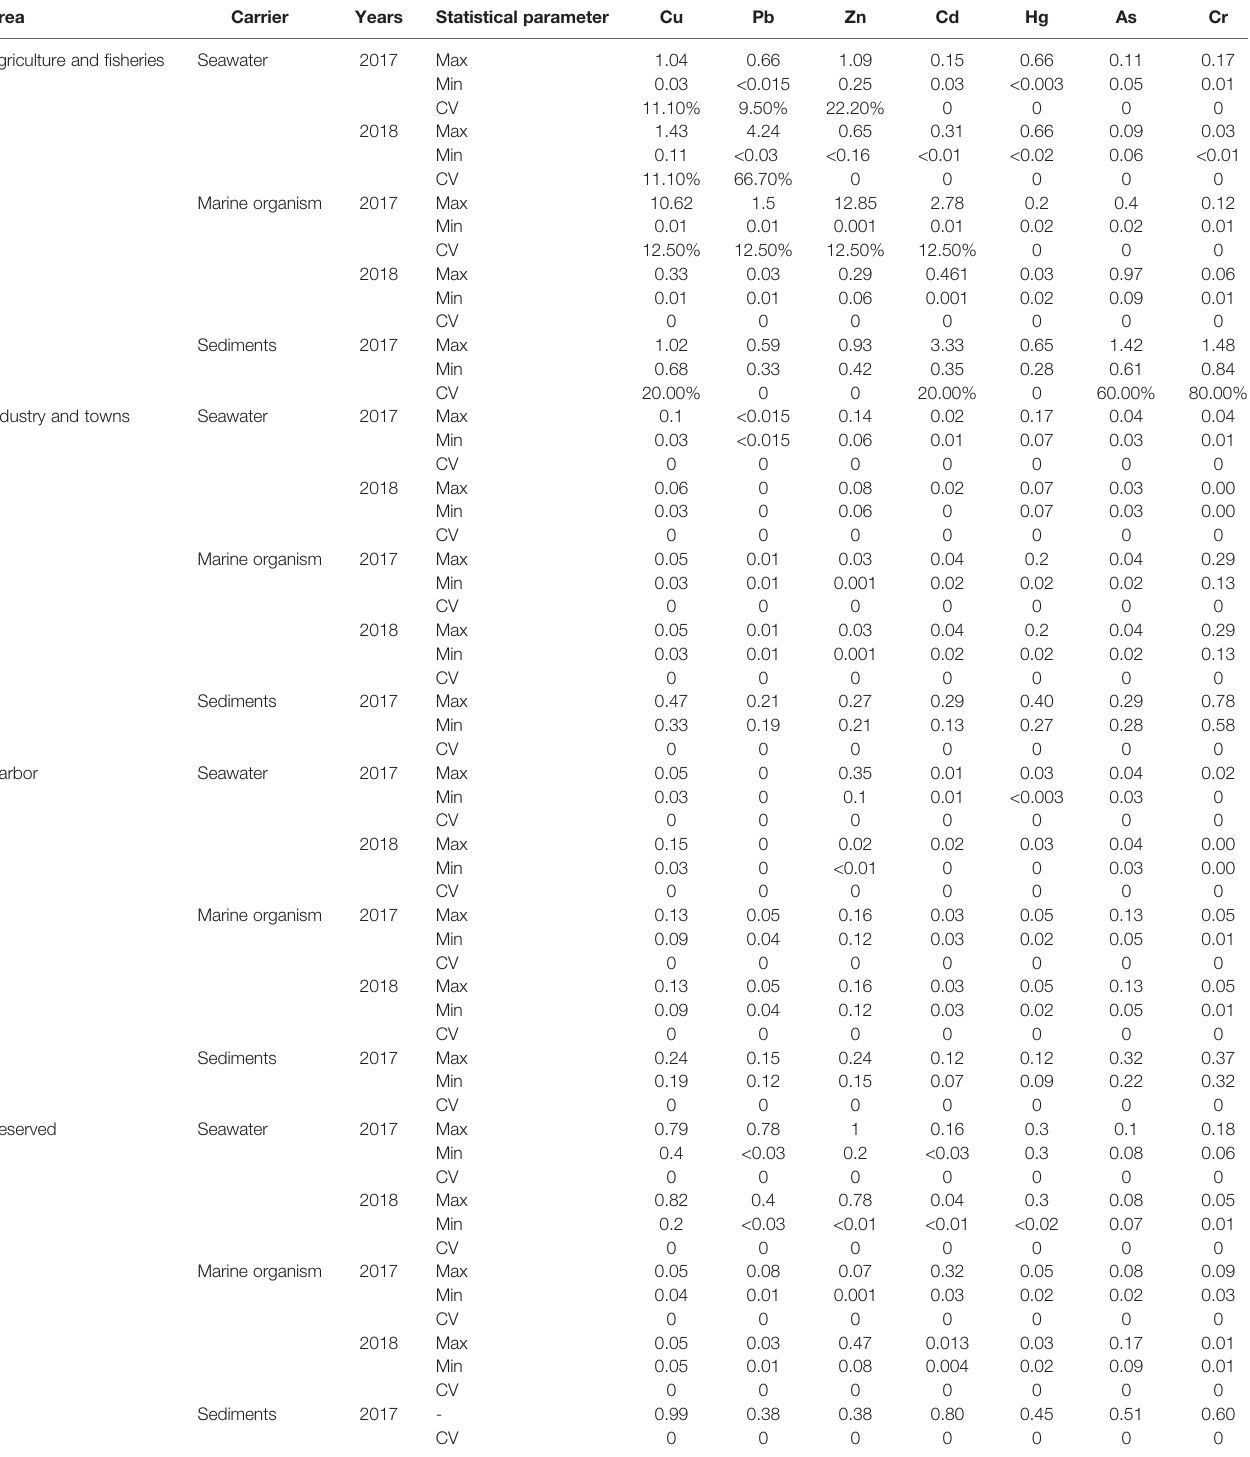
TABLE 1 | Results of quality index evaluation.